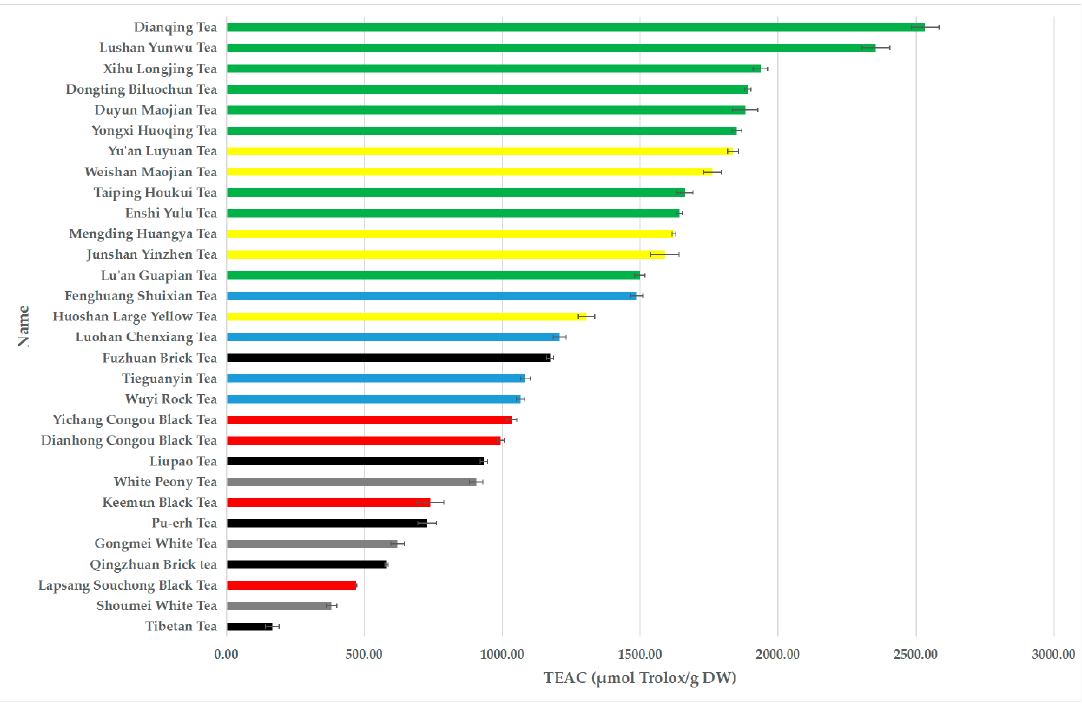
Antioxidants 2019 , 8 , x FOR PEER REVIEW Figure 2. The TEAC values of 30 teas. Figure 2. The TEAC values of 30 teas.